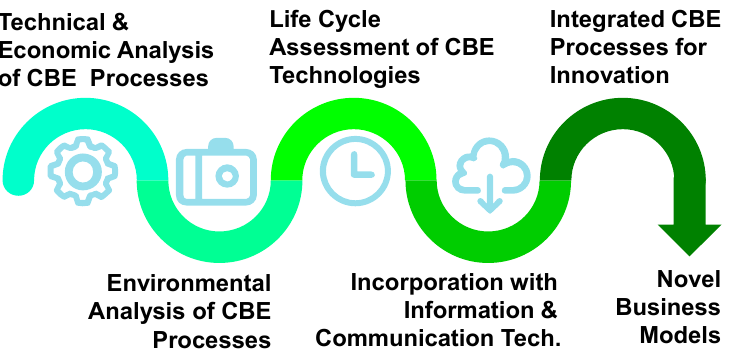
Figure 8. Pathway of process integration for innovation. Abbreviations: CBE (circular bioeconomy).